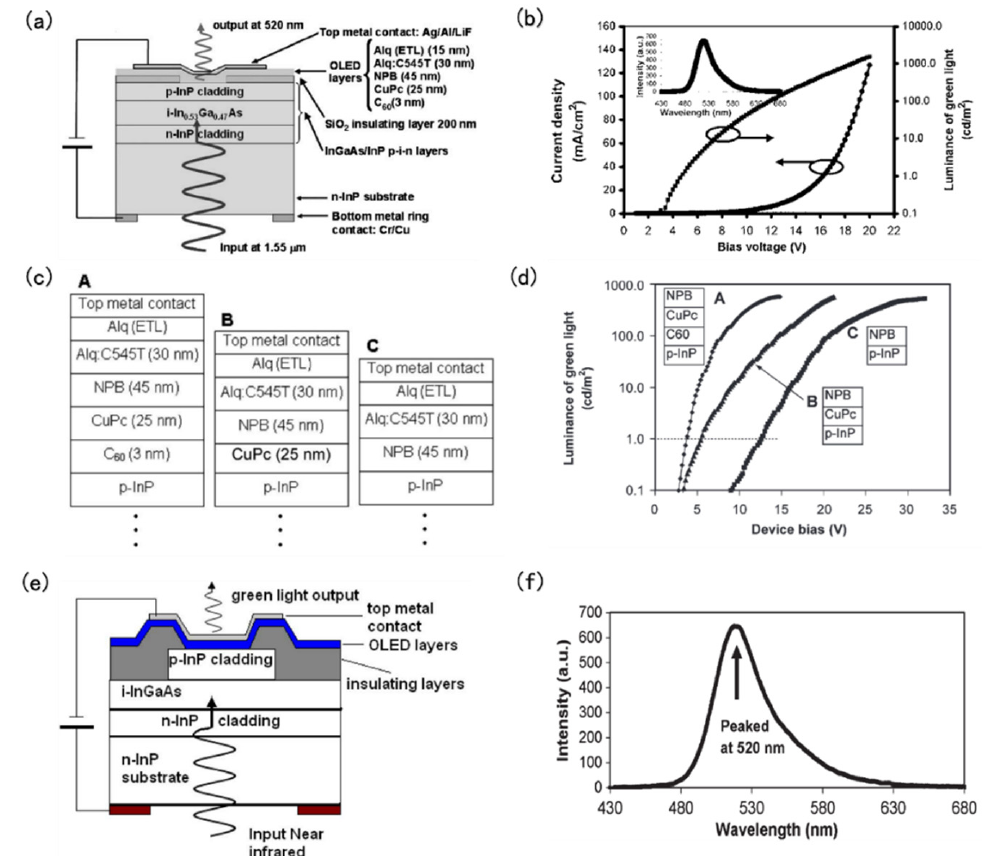
Figure 6. Structures and performance characterization of hybrid organic–inorganic SWIR-to-visible upconversion devices. ( a ) Structure of the inorganic–organic upconversion device. ( b ) Current– voltage–luminance curves of the upconversion device under 1.5 µ m infrared illumination (input power density of 1.1 mW/mm 2 ). The inset shows the emission spectrum from the OLED of the integrated upconversion device with a wavelength peak at 520 nm (green light) [49]. Copyright 2007, Applied Physics Letters. ( c ) Schematic diagram of the three configurations of the hole transform layer (HTL) at the semiconductor–organic interface of the integrated devices. ( d ) OLED green emission luminance of the device A, B, C as a function of the device bias. ( e ) Schematic diagram of the cross-section of one organic–inorganic upconverter device. ( f ) Emission spectrum from the OLED of the integrated upconverter, the peak wavelength of this OLED is 520 nm (green light) [50]. Copyright 2007, IEEE Transactions on Electron Devices.